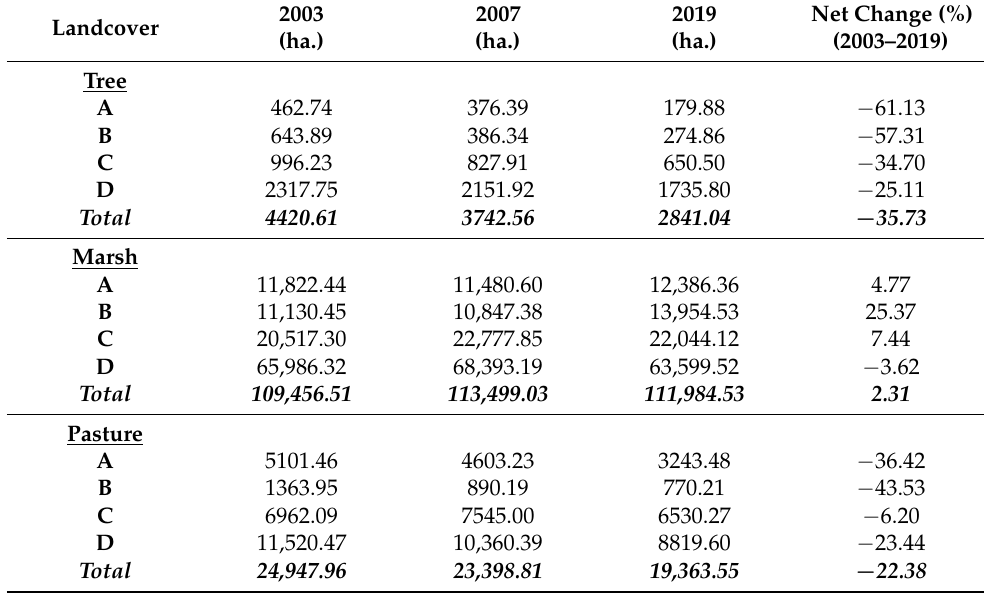
Table 1. The amount and percentage loss of three land ‐ cover types—tree, marsh, and pasture—over each section and the total area spanning two parishes, Calcasieu and Vermillion, on the western Louisiana Gulf Coast. Sections A, B, C, and D represent areas delineated for this study within the two parishes (for details see Figure 1).